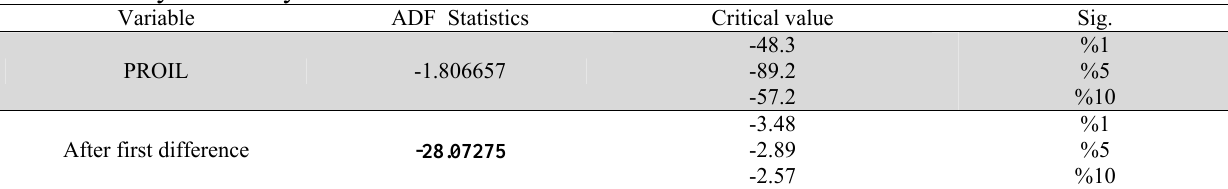
The summary of Dickey Fuller test